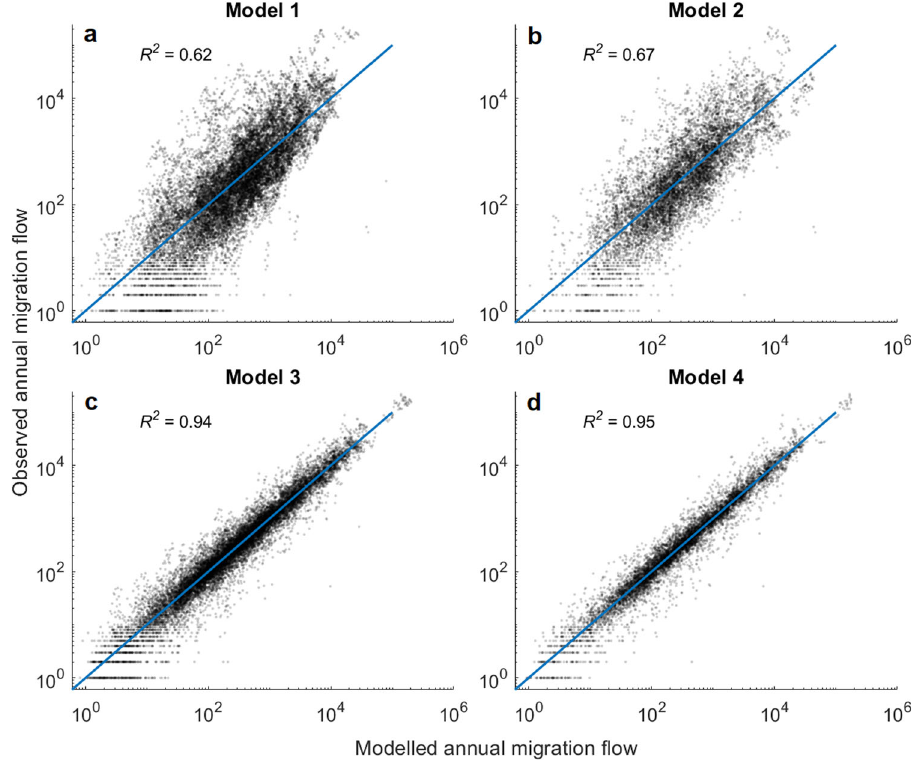
Fig. 1 Modelled and observed migration fl ows. Each marker represents the observed and modelled fl ow from a country of origin i to a country of